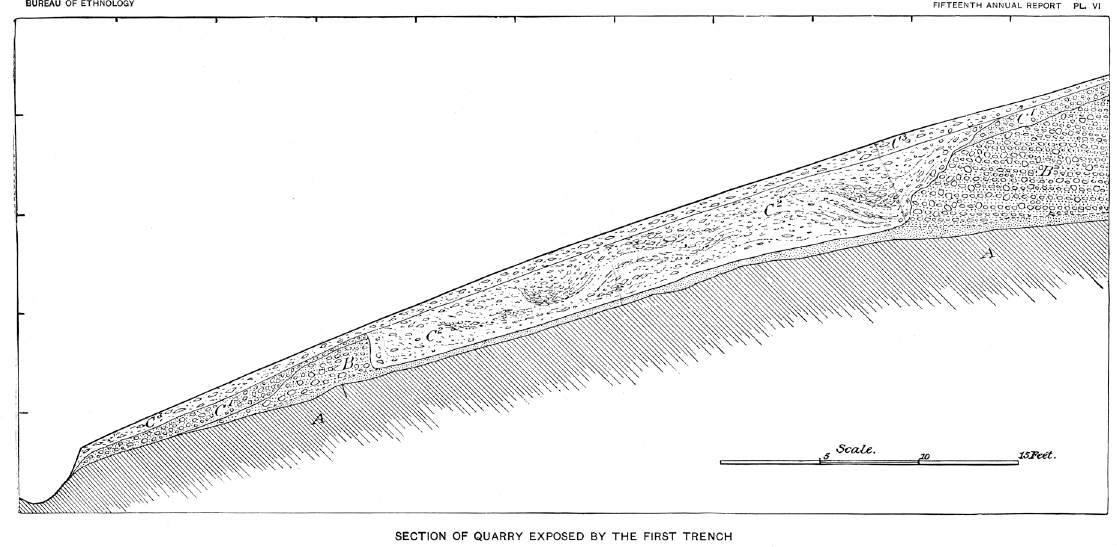
Figure 6. Section of the deposits at Piney Branch showing colluvial strata that may have missing-time erosional surfaces. After Holmes 1897: plate VI. [Original caption: Section of quarry exposed by the first trench. A, Mica schists; b, Potomac (Mesozoic) bowlder beds; c 1 , Preartificial slope gravels; c 2 , Deposits of shop refuse, showing traces of pits; c 3 , materials rearranged by natural forces since the period of